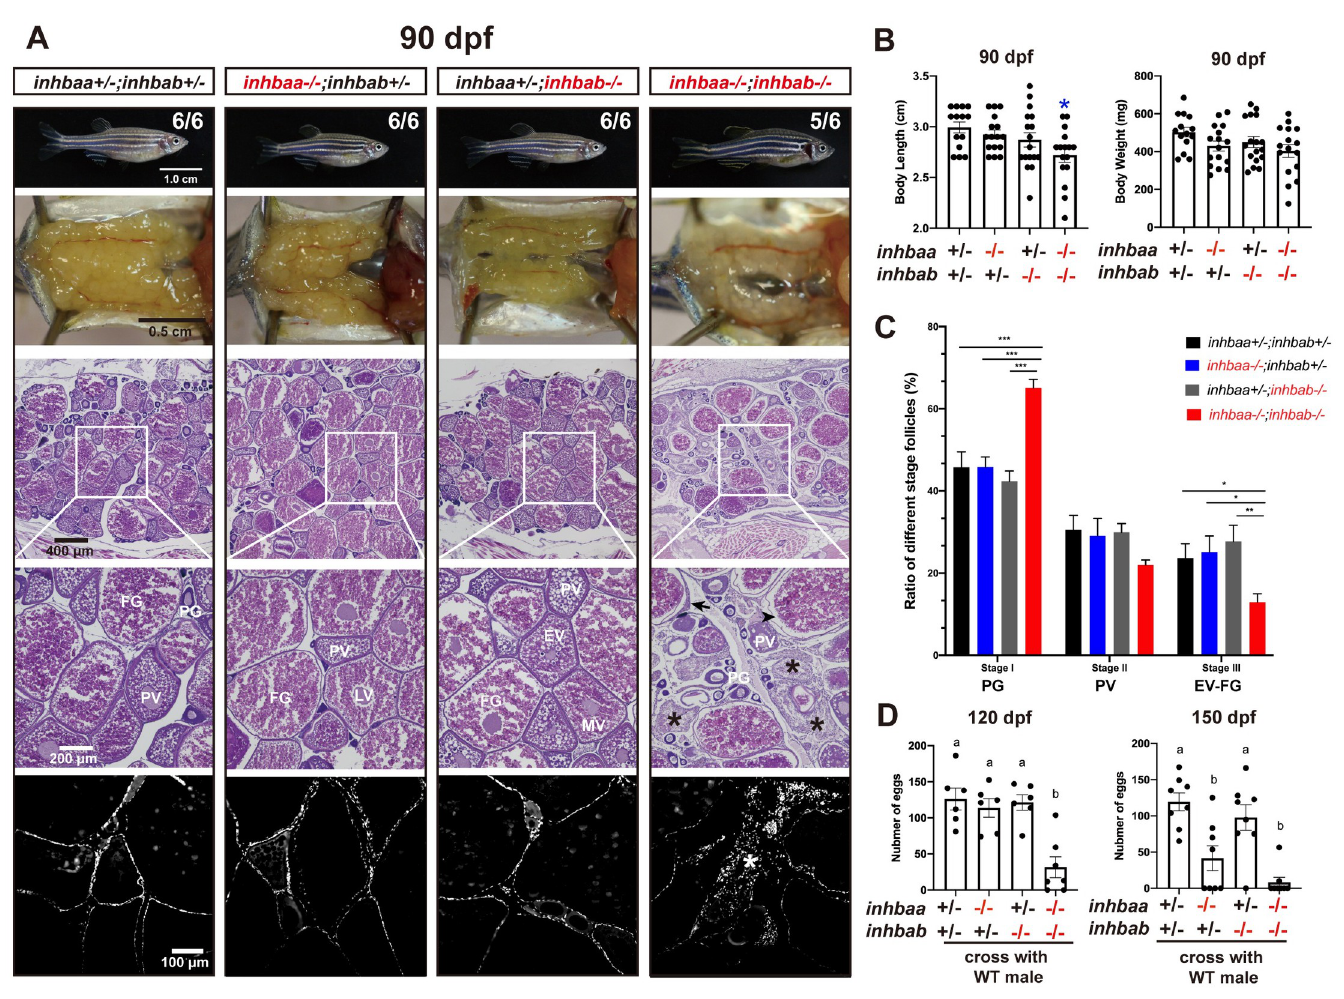
Fig 7. Follicle development and fecundity in young and mature females of β A mutants. (A) Morphology, gross anatomy and histological analysis of activin β A female mutants at 90 dpf. Follicles from the control ( inhbaa +/- ;inhbab +/-)and single mutants ( inhbaa-/- , inhbab-/- ) showed normal growth and ovarian development. The double mutant ( inhbaa -/-; inhbab -/-)started to show stromal cell hyperplasia (asterisk), granulosa cell hypertrophy (arrow) and follicle atresia (arrowhead). The overproliferation of the stromal cells is also shown by DAPI staining for nuclei (bottom). The boxed areas are shown at higher magnification below. The numbers shown in the photos indicate the total number of fish examined (lower) and the fish exhibiting similar phenotype to that shown (upper). (B) Body length and body weight of activin β A mutants at 90 dpf. (C) Follicle composition in the ovaries of the activin β A mutants at 90 dpf (n = 5). ( � p < 0.05; �� p < 0.01; ��� p < 0.001). PG, primary growth (stage I); PV, previtellogenic (stage II); EV-FG, vitellogenic (stage III). (D) Fertility and fecundity of activin β A female mutants at 120 and 150 dpf. The mutant females were bred with normal WT males by natural breeding. Different letters indicate statistical significance (p < 0.05). Each dot represents the average egg number of four females from each spawning test (n = 6-8